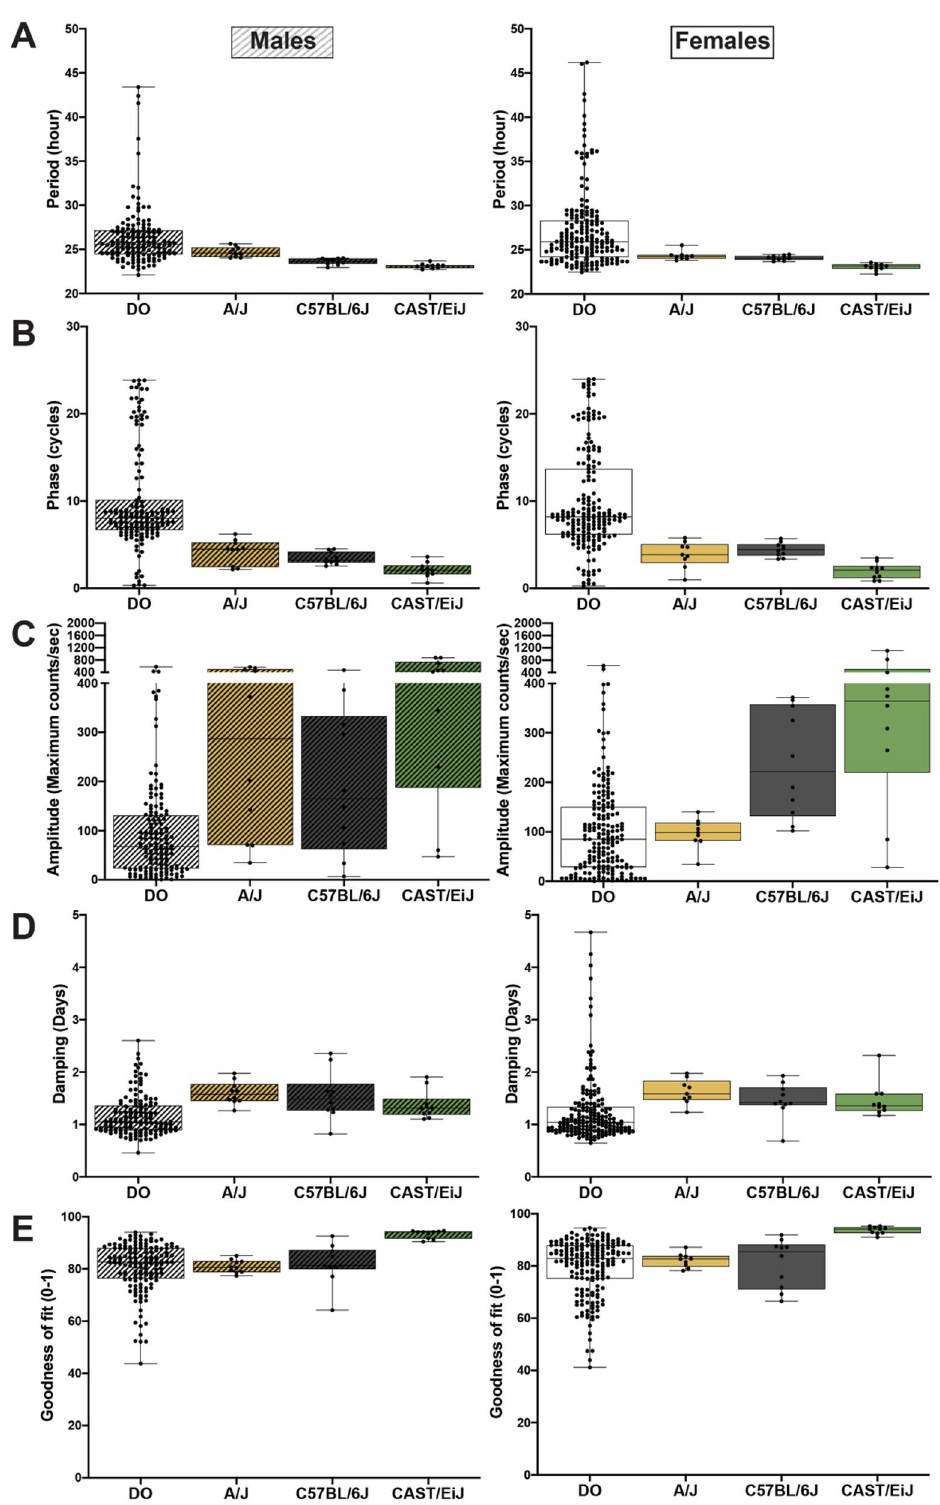
Figure 3. Distribution of circadian parameters in DO mice and two extreme founder strains, A/J and CAST/ EiJ, along with C57BL/6J strain. (A) Period, (B) phase, (C) amplitude, (D) damping rate and (E) goodness of fit of ensemble Bmal1-dLuc rhythms in primary fibroblast cultures. Lines in bars indicate median and the whiskers indicate Min to